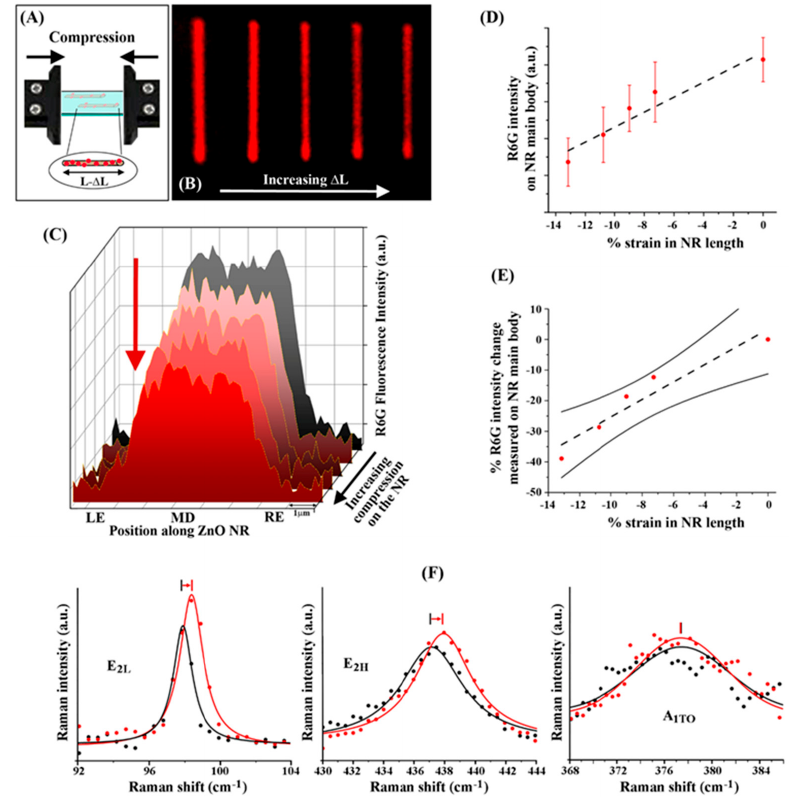
Figure 3. Representative R6G fluorescence intensity along individual ZnO NRs linearly decreasing with the addition of incremental compressive strain. ( A ) The schematic shows varying levels of uni- axial compressive strain being applied to R6G/ZnO NRs embedded in a PDMS matrix. The resulting NR length is depicted as L − Δ L, where L is the length of the ZnO NR at rest and Δ L is the change in length due to the compressive strain. ( B ) The compiled fluorescence panel qualitatively displays the decreasing intensity from the R6G emission on the ZnO NR with increasing Δ L, correlating to a decreasing overall NR length. ( C ) The cascading plot shows the R6G fluorescence intensity along the different position on the ZnO NR versus the levels of applied compression. The left-end, middle, and right-end positions of the ZnO NR are denoted as LE, MD, and RE, respectively. The grey graph is the farthest back of the plot shows the R6G fluorescence intensity under the neutral state of the ZnO NR. The graphs cascading towards the forefront correspond to increasing compression on the NR. The decrease in fluorescence intensity with increasing compressive strain is marked with a red arrow. ( D ) The plot displays average R6G intensity on the NR against the % strain in its length under compressive strain. The more negative values in the x-axis denote higher compression states com- pared to the rest state at 0% strain. The error bars correspond to the standard deviation of the 115 ZnO NRs studied under compression. ( E ) The plot shows the % R6G intensity change measured on the NR versus the % strain in NR length under compressive strain. The solid black lines above and below the data points display the 95% confidence interval. As a visual guide, the dashed lines in ( D , E ) are linear fits through the data points. ( F ) Raman spectra were collected of a pristine ZnO NR embedded in PDMS under no stress (black) and subsequently under compression (red) for the char- acteristic phonon modes of E 2H , E 2L , and A 1TO in wurtzite ZnO NRs. The observed shifts in E 2H and E 2L peaks to a higher energy along with the unchanged A 1TO peak confirms that the NRs in this case are under uniaxial compressive strain.